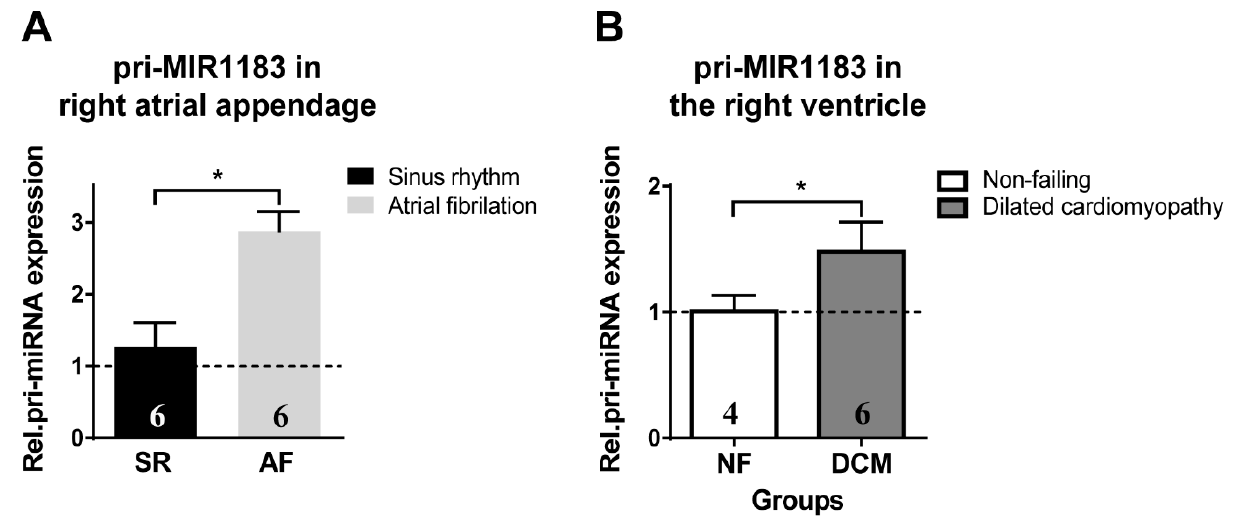
Figure 4. Chronic expression of pri-miR-1183 in healthy versus diseased atrial and ventricular human myocardium. ( A ) Increase in relative mRNA expression of pri-miR-1183 in right atrial appendage tissue from patients with normal sinus rhythm versus patients with persistent atrial fibrillation. ( B ) Increase in mRNA levels of pri-miR-1183 in right ventricular myocardial samples from the following heart groups: non-failing donor hearts (NF) and hearts with dilative cardiomyopathy (DCM). The dashed line represents the baseline expression. Statistical difference determined by one-sample t -test. * p < 0.05, n —number of hearts per group is indicated within bar charts.